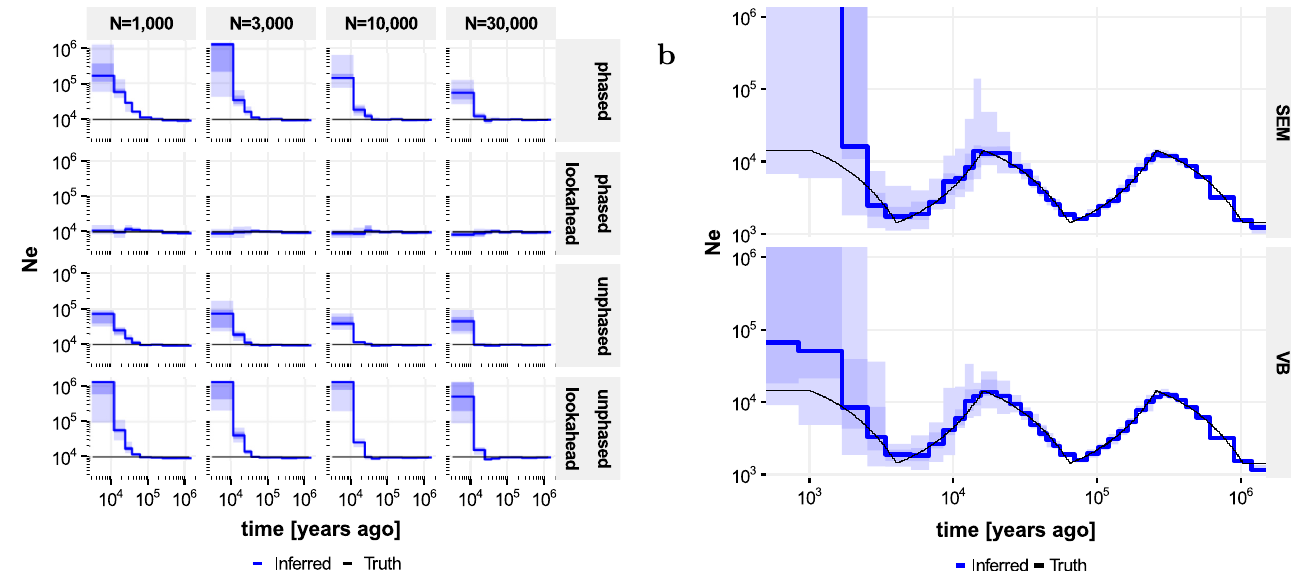
Fig 2. Accuracy of population size inferences in simulated data. Shown are true population sizes (black) and median inferred population sizes across 15 independent runs (blue); shaded areas denote quartiles and full extent. a Impact of lookahead, phasing and number of particles on the bias in population size estimates for recent epochs, for data simulated under a constant population size model. b Inference in the “zigzag” model on phased data using lookahead and 30, 000 particles, comparing inference using stochastic Expectation Maximization (SEM) and Variational Bayes (VB).